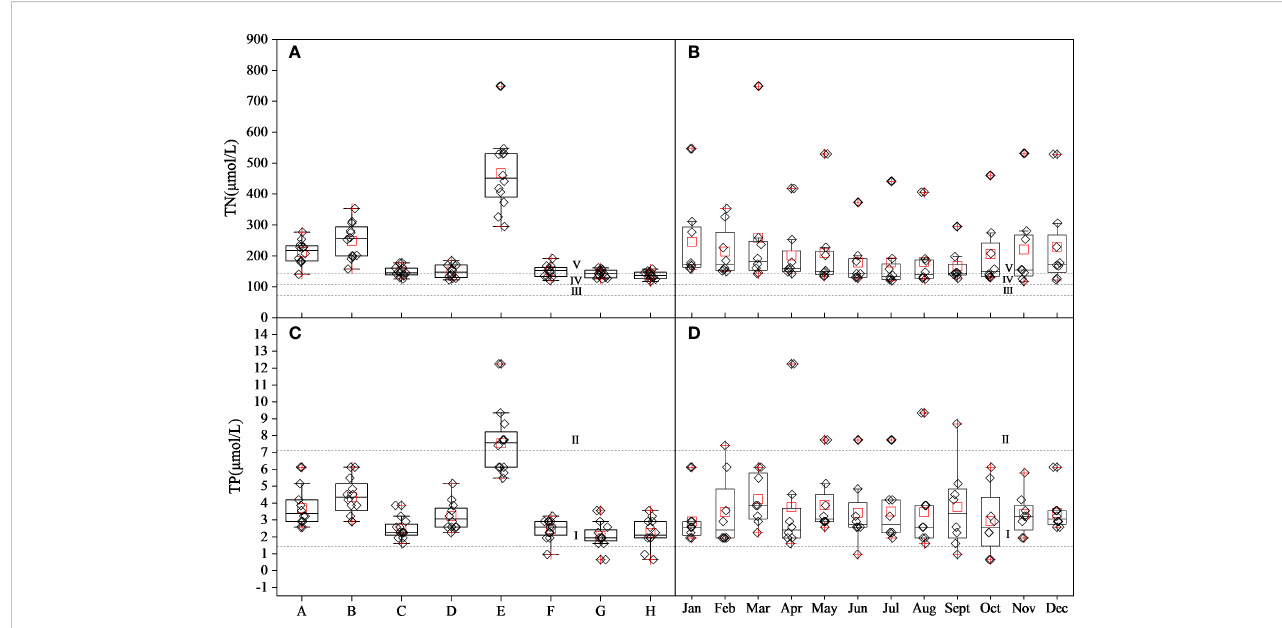
FIGURE 2 Spatiotemporal distribution patterns of TN (A, B) and TP (C, D) in rivers of the PRE from January to December. The black lines and red boxes, upper and lower edges, black lines, red crosses inside and outside the box and dotted lines represent the median and mean, 25th percentile and 75th percentile, < 99 the percentile and > 1th percentile, minimum and maximum values and water quality standard grades for all data,